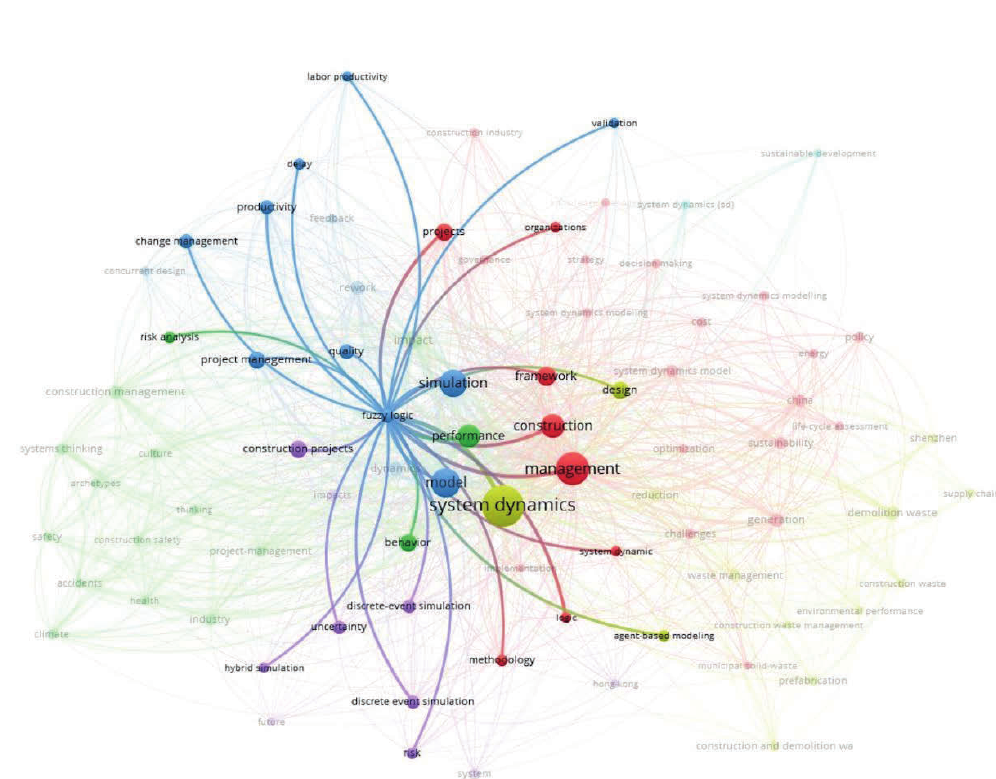
Fig. 9. Coexistence of author’s keywords. Source: created by the author with VOSviewer software based on Clarivate analytics